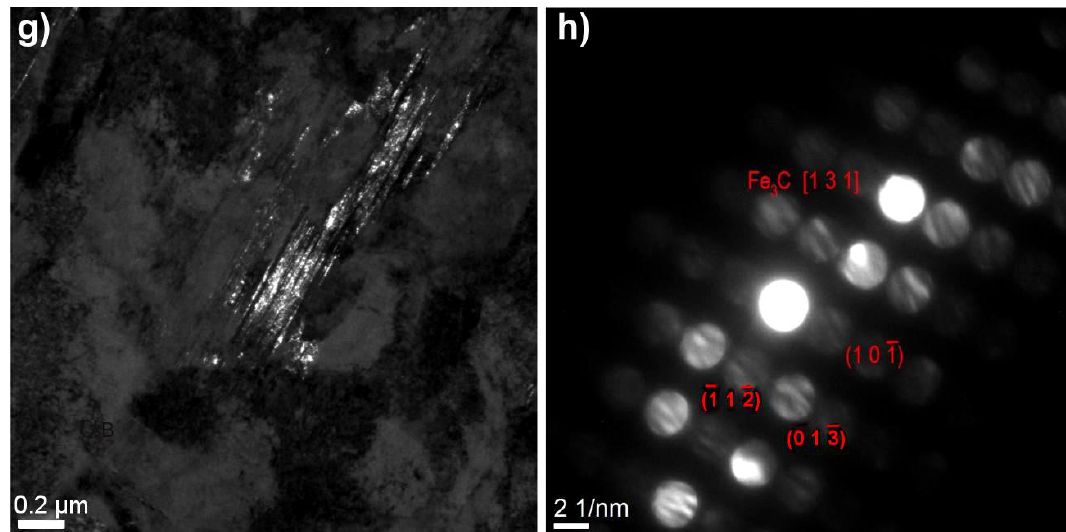
Figure 11. Plate martensite with interlath carbides located next to retained austenite and bainitic ferrite characterized by high dislocation density in 5Mn-1.5Al steel ( a ) bright field, ( b ) magnification of the fragment from ( a ), ( c ) dark field from the austenite reflex (200) ( d ), microdiffraction solution from the retained austenite lath, ( e ) dark filed from martensite ( 211 ) , ( f ) microdiffraction solution from the martensitic plates area, ( g ) dark field from the cementite ( 112 ) , ( h ) microdiffraction solution from carbides area.